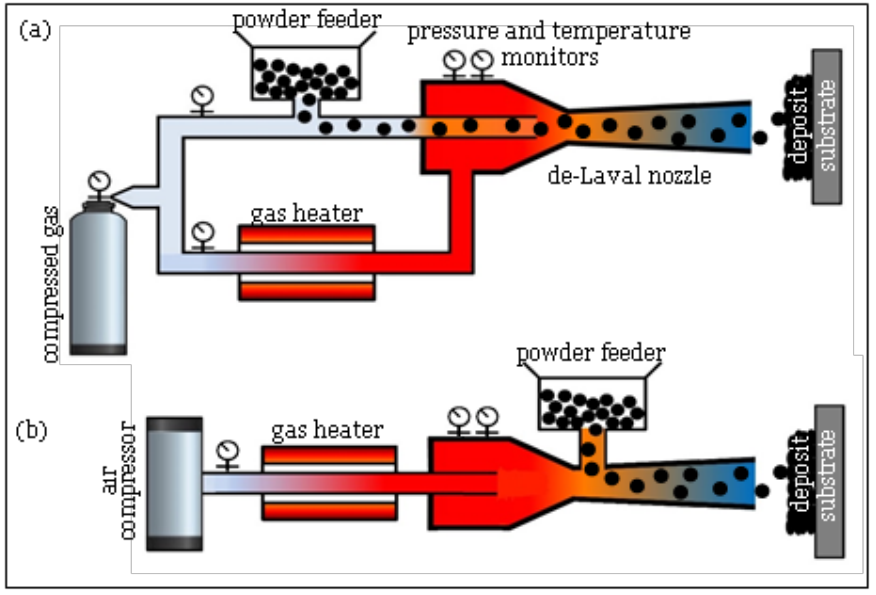
Figure 6. Schematic view of ( a ) high and ( b ) low pressure CS.